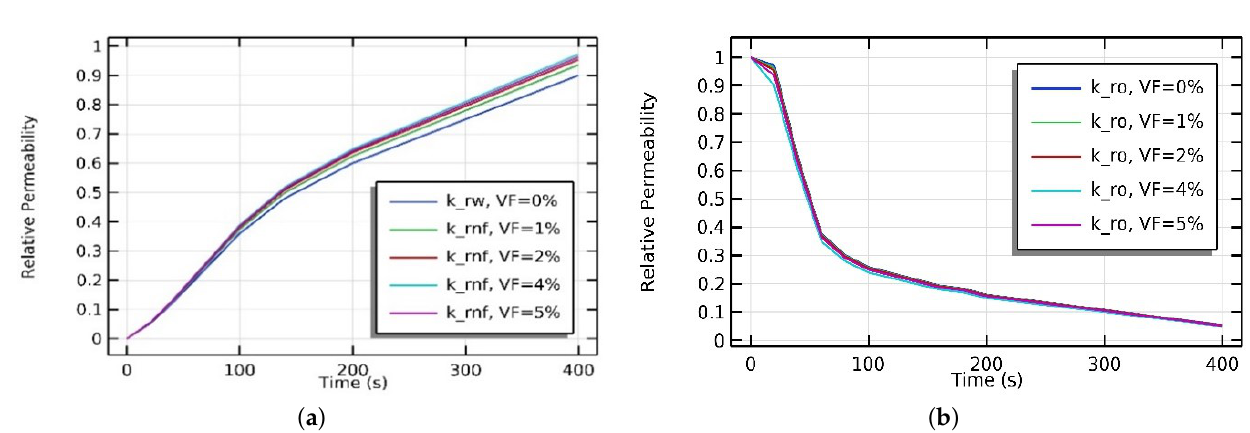
Figure 14. The relative permeabilities of nanofluid with different nanoparticle VFs (0, 1, 2, 4 and 5%) of and ( b ) The relative permeabilities of oil with different nanoparticle VFs (0, 1, 2, 4 and